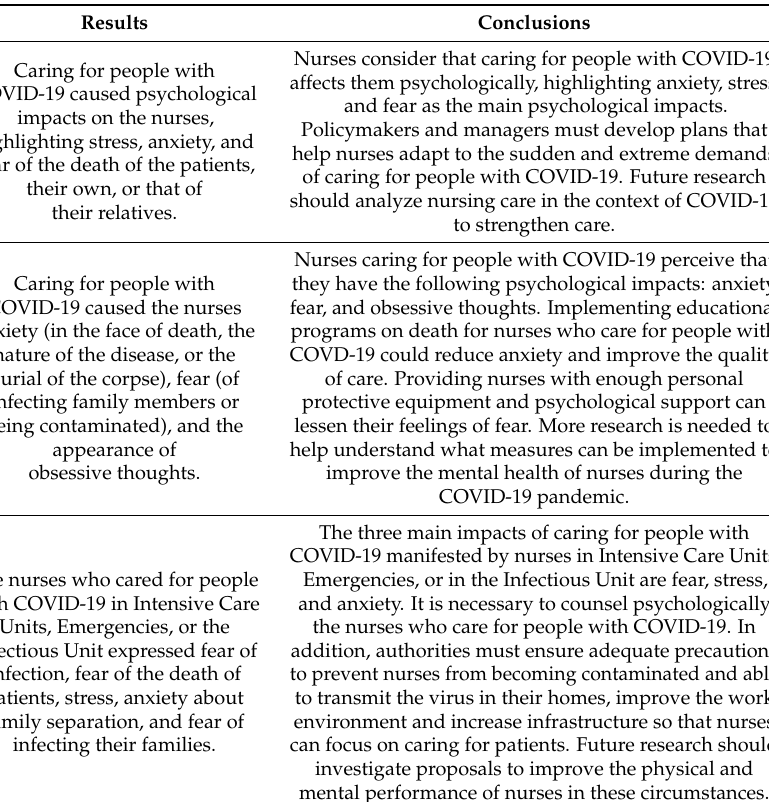
Table 2. Summary of the main characteristics of the analyzed